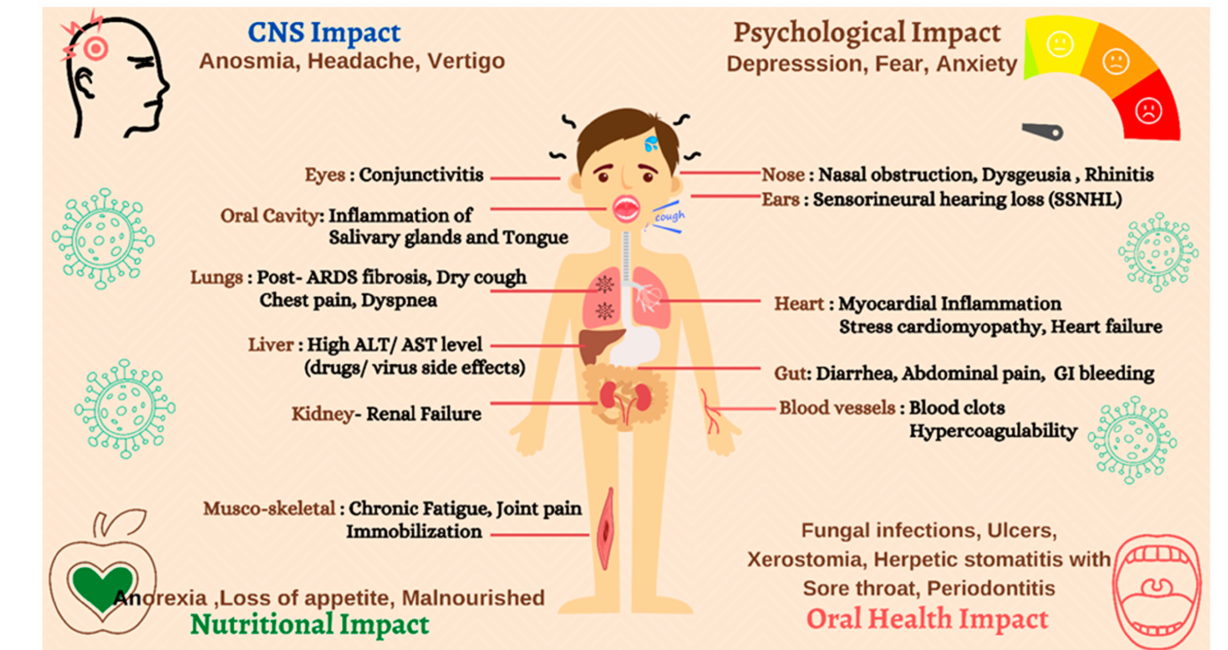
Figure 2. Summary of prolonged post-COVID-19 symptoms in recovered